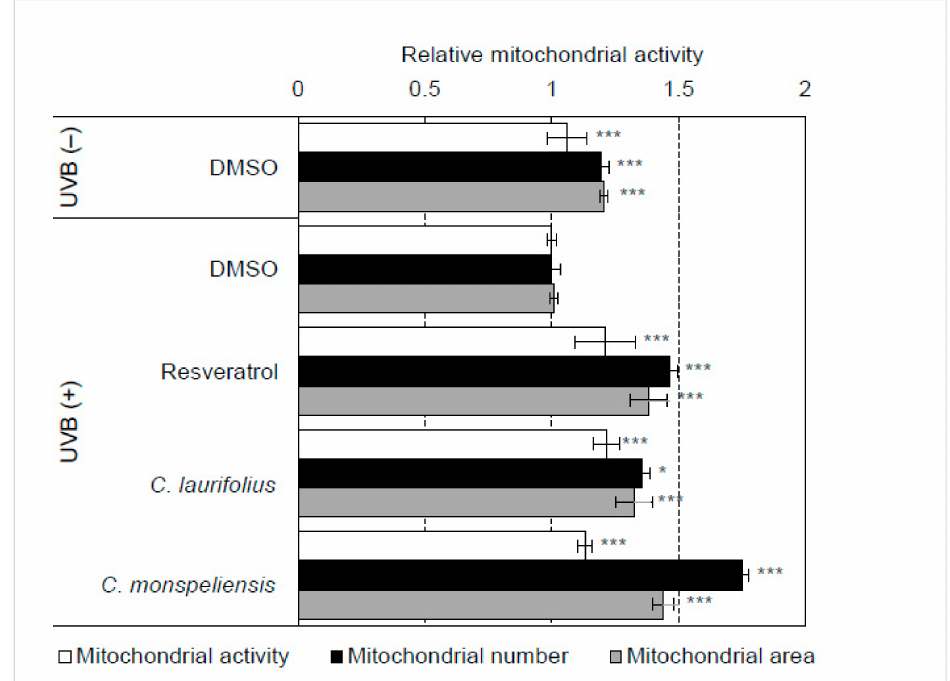
Figure 5. Effects of essential oils on UVB-induced mitochondrial damage. HaCaT cells were irradiated with 10 mJ/cm 2 and then treated with essential oils (final concentration: 100 ng/mL) for 48 h. The effects of essential oils on the UVB-induced mitochondrial damage were evaluated by fluorescence imaging using MitoTracker Red CMXRos and MitoTracker Green FM. Mitochondrial activity and the number and area of mitochondria were analyzed using IN Cell Analyzer 2200 (GE Healthcare) and IN Cell Investigator high-content image analysis software (GE Healthcare) as mentioned above. Statistical significance was determined by using a two-sided Student’s t -test. Statistical significance was evaluated by comparison with the control irradiated with UVB and defined as p < 0.05 (* p < 0.05; *** p < 0.001). Values are means ± SEM ( n =